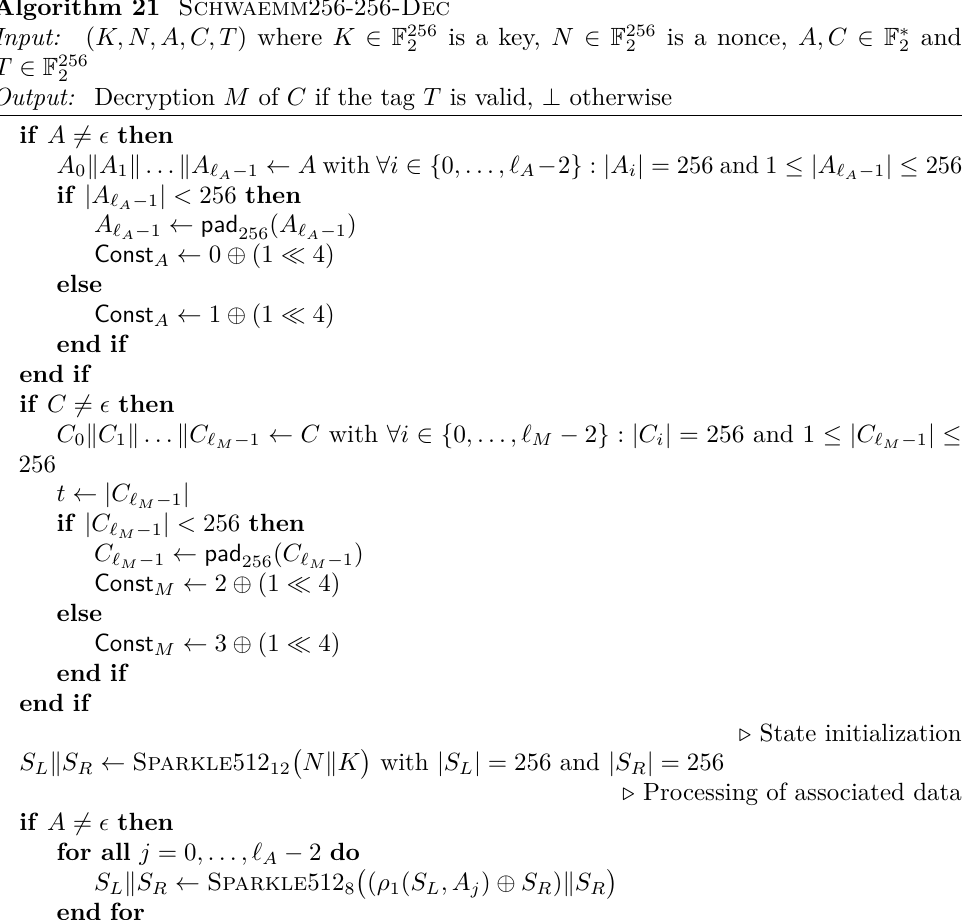
Algorithm 21 Schwaemm 256-256